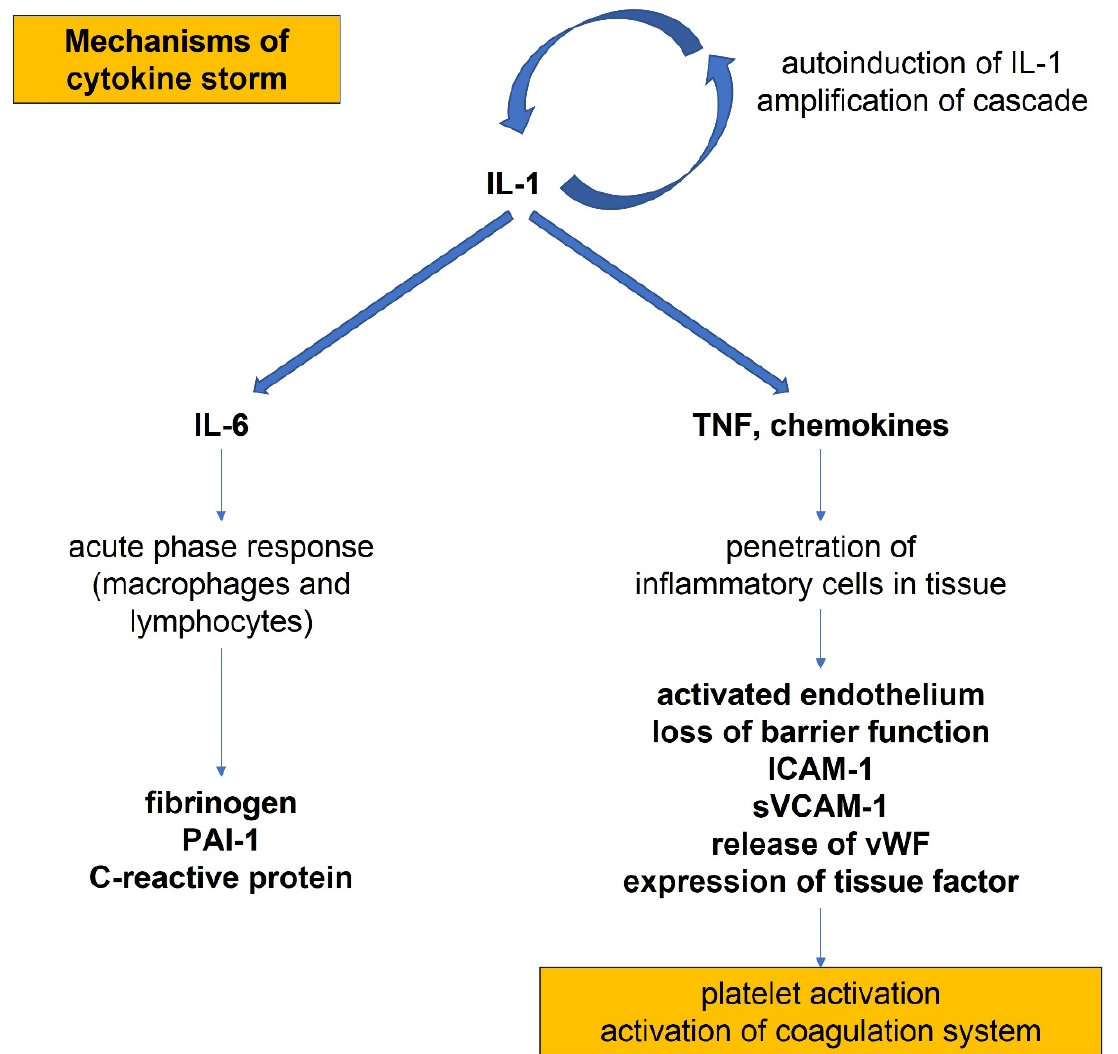
Figure 4. Mechanisms of cytokine cascade and activation of the coagulation system in SARS-CoV-2 infection, showing the autoinduction of interleukins and the amplification of the inflammatory cascade. Abbreviations: IL: interleukin; PAI: plasminogen activator inhibitor; TNF: tumor necrosis factor alpha; ICAM: intercellular adhesion molecule; sVCAM: serum vascular cell adhesion molecule; vWF: von Willebrand factor.